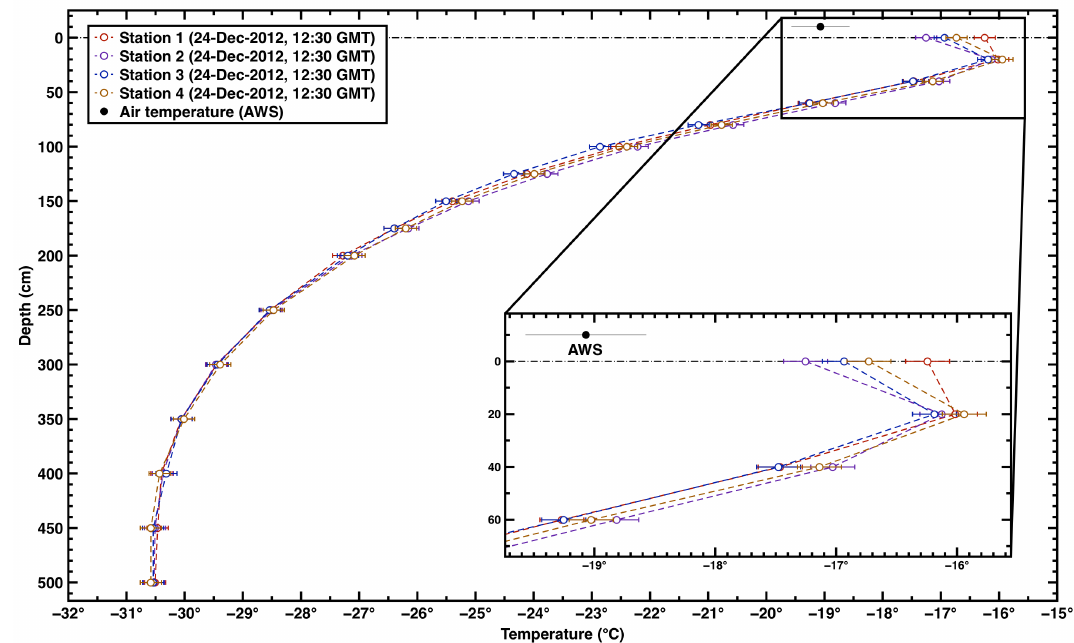
Figure 11. Snapshot temperature readings for PRD-string stations #1–4, taken on 24 December 2012 at ∼ 12:30GMT, showing the temper- ature inversion with colder air (AWS data) and upper surface over warmer near-surface